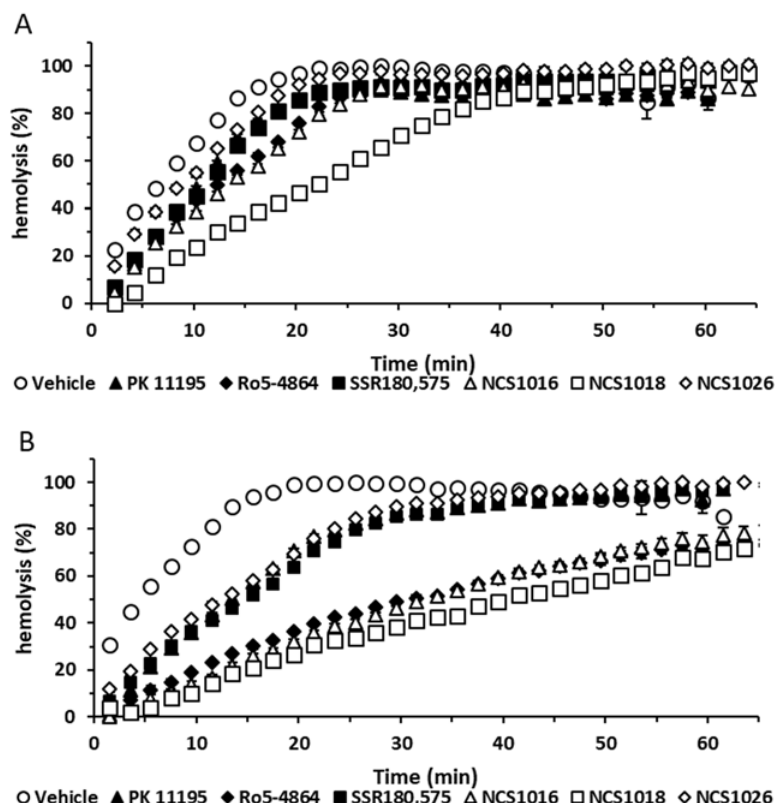
Figure 4. Sorbitol-induced hemolysis is modulated by the TSPO ligands in infected red blood cells. Infected RBCs at 2 to 5 % parasitemia were washed three times in a culture medium, without serum, and resuspended at 50% hematocrit in a media containing 10 µM ( A ) or 50 µM ( B ) TSPO ligands. Hemolysis was quantified at several time-points, by absorption at 540 nm wavelength. Data are presented as mean ± SEM; N = 4. Differences between each ligand and control condition (vehicle) were considered significant when p < 0.01.